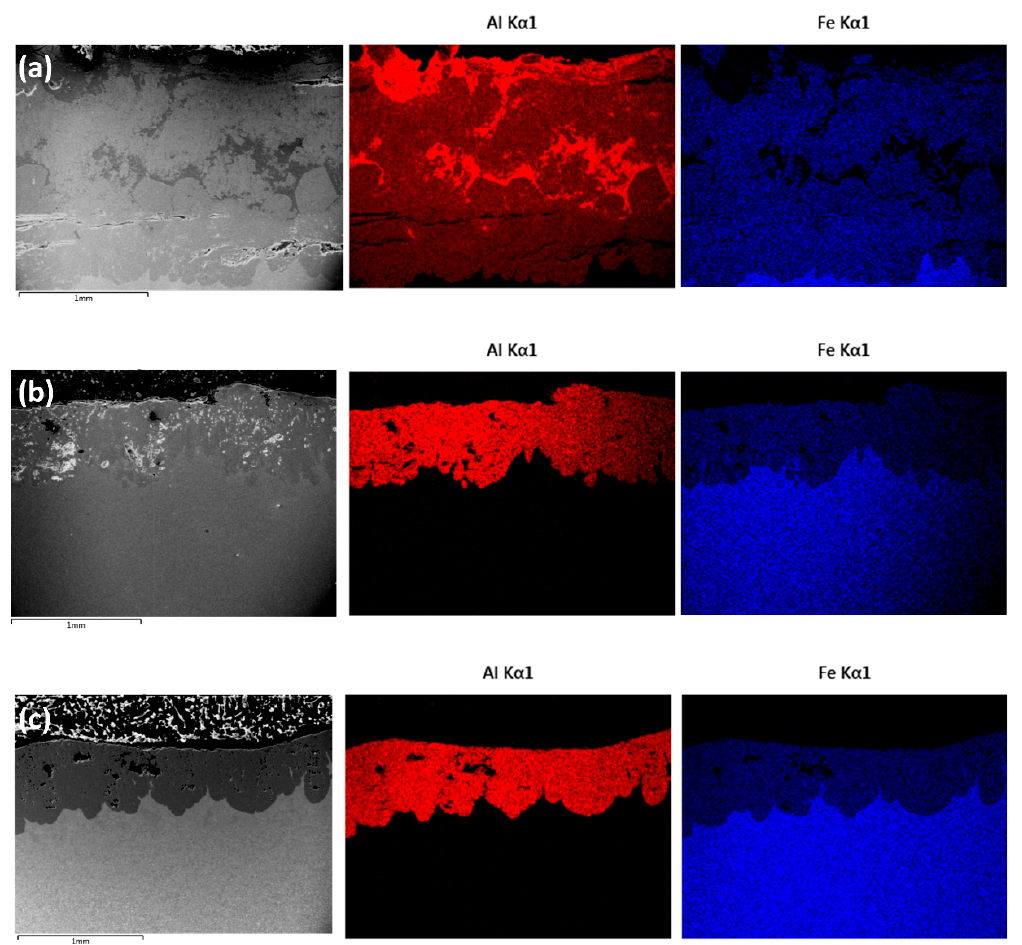
Figure 5. Cross-section overview of the samples after heat treatment at 550 °C with EDS maps showing an overall homogenous distribution of Al and Fe in the coating: ( a ) 48 h, ( b ) 72 h and ( c ) 96 h (images obtained in BSE imaging mode).